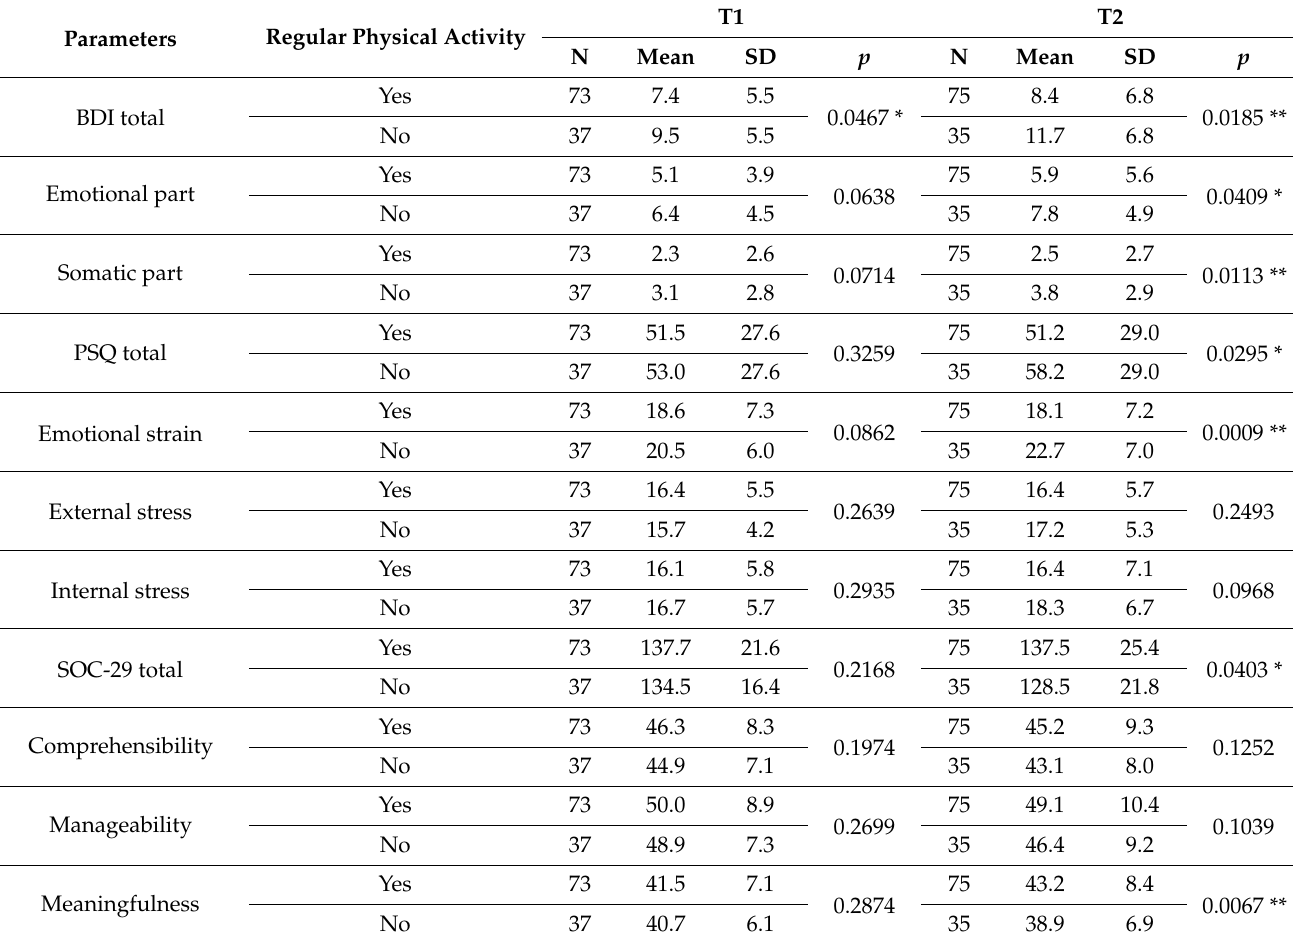
Table 6. Comparison of the mean values of the tested parameters in the groups of physically active and inactive students (Student t -test for independent